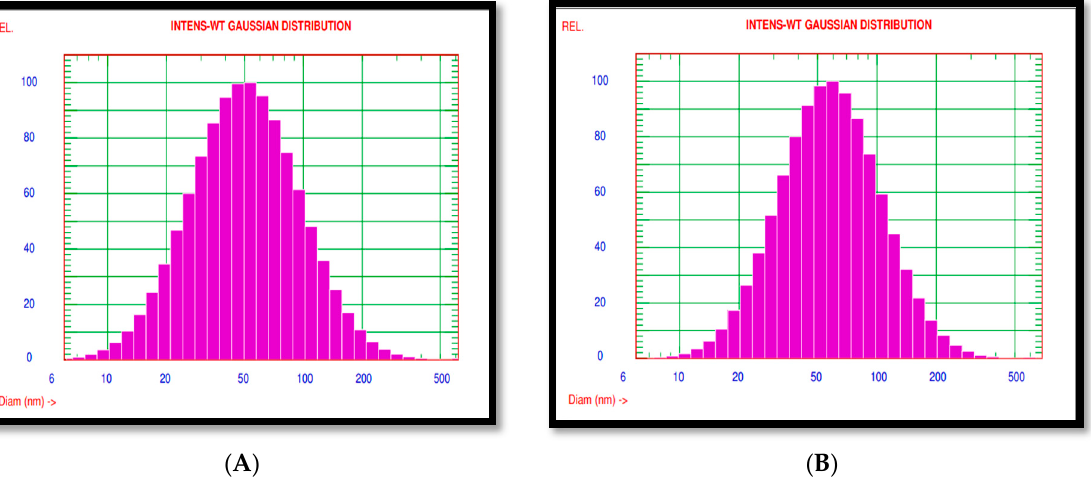
Figure 3. ( A ) PSAimage of A. indica -based AgNPs at 61.70 nm. ( B ) PSA image of P. pinnata AgNPs at 68.80 nm.